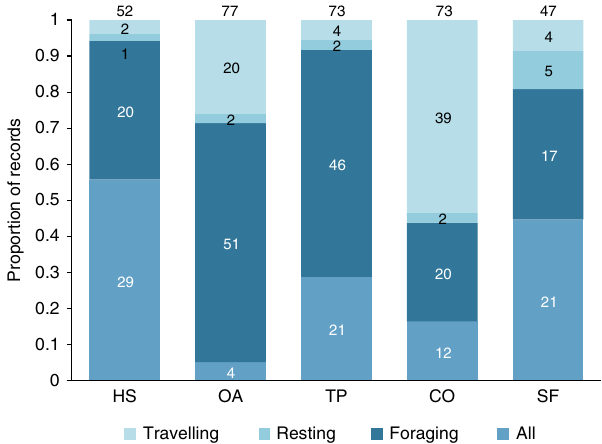
Fig. 2 Activities of primates in each anthropic land cover (ALC) type. The proportion (and total numbers above each column and within column sections) of records for traveling, resting, foraging or all activities in different ALC types is indicated. ALCs, include human settlements (HS), open areas (OA), tree plantations (TP), connectors (CO), and secondary forests (SF). The total number of records varies because one study can report activities for more than one primate species whereas others do